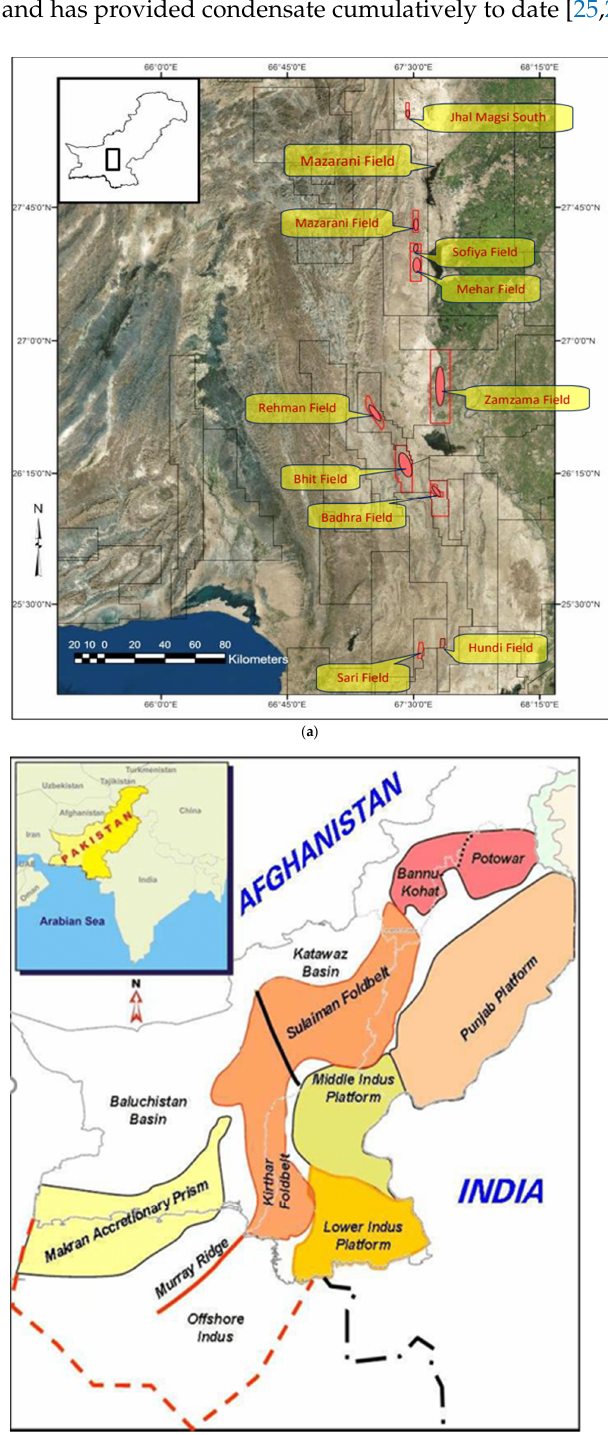
In 1998, with estimated wet gas in place at discovery, the Zamzama Field was discovered and has provided condensate cumulatively to date [25,26].